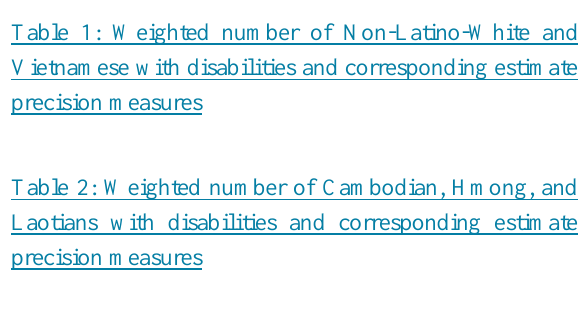
imprecision. Table 1: Weighted number of Non-Latino-White and Vietnamese with disabilities and corresponding estimate precision measures Table 2: Weighted number of Cambodian, Hmong, and Laotians with disabilities and corresponding estimate precision